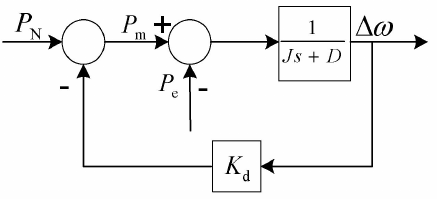
Figure 5. Simple box diagram of the system with primary